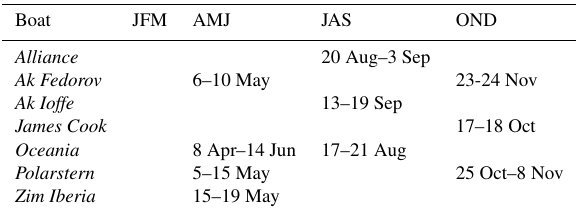
Table 2. MAN period of measurements during the year